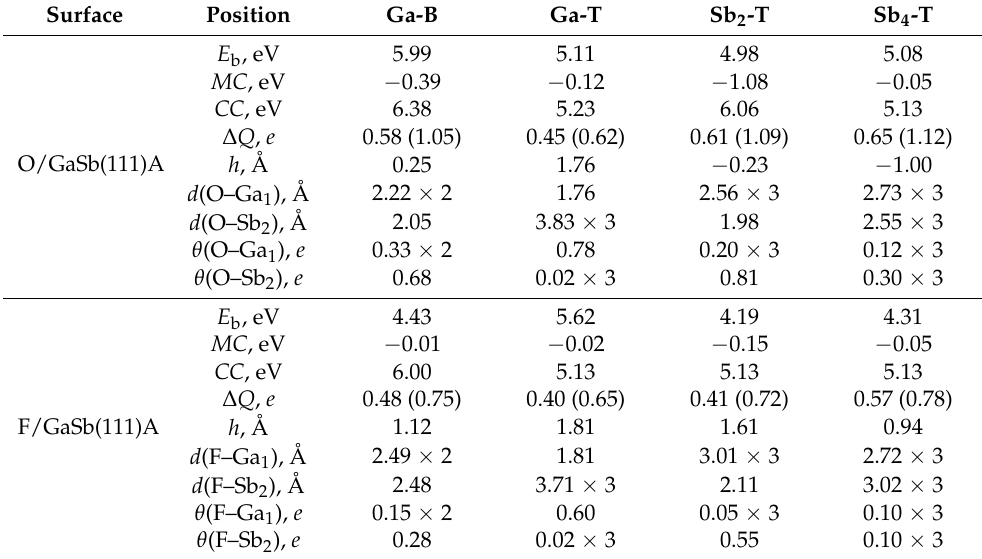
Table 2. Mechanical ( MC ) and chemical ( CC ) contributions to the binding energy ( E b ), charge transfer to adatom ( ∆ Q ) obtained by DDEC6 and Bader (in brackets) methods, height of adatom above surface ( h ), distance between adatom and surface atoms ( d ), as well as corresponding overlap population ( θ ) in the case of oxygen and fluorine adsorption on the GaSb(111)A